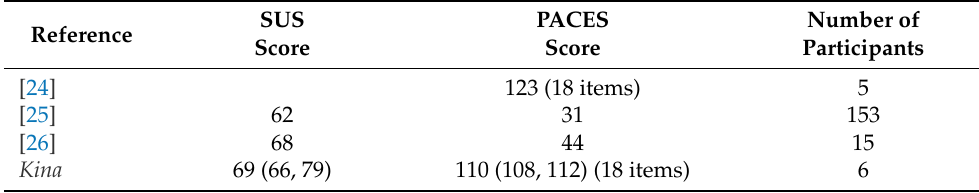
Table 10. Kina ’s SUS and PACES scores compared to other